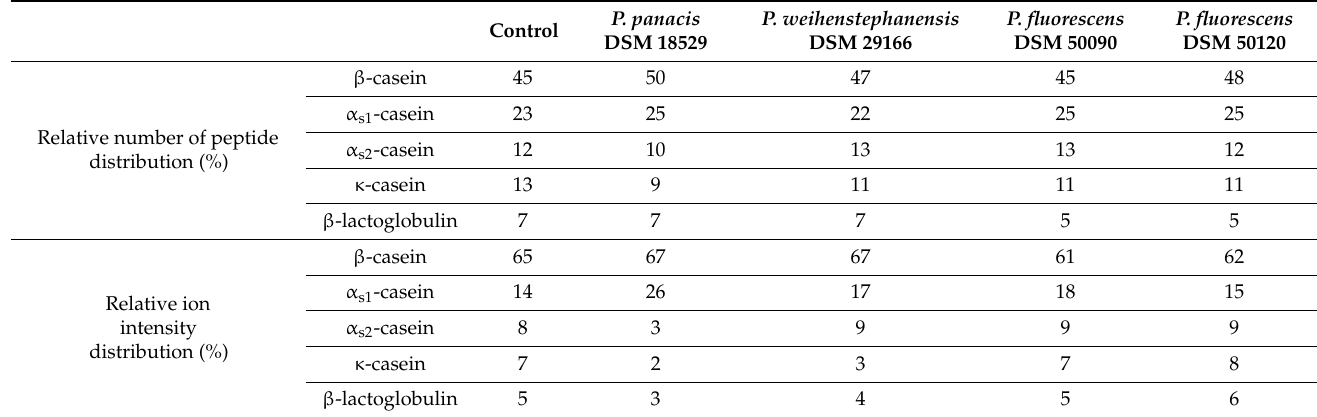
Table 2. Relative distribution of the number of peptides and ion intensities of peptides identified as derived from the five major milk proteins by peptidomic analysis using nanoLC timsTOF Pro MS/MS of skimmed UHT milk inoculated with the four Pseudomonas strains and the control after 45 days of